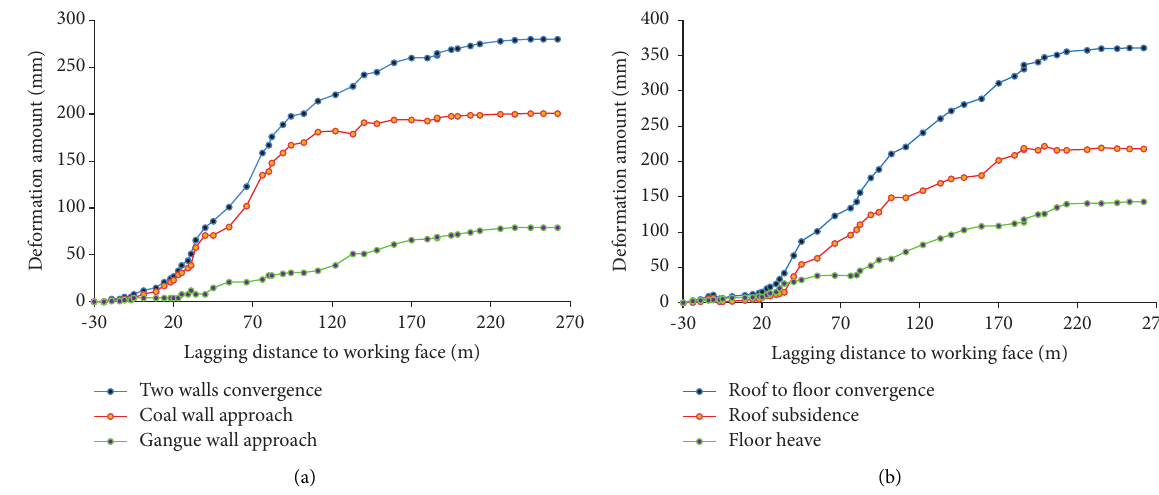
Figure 21: Monitoring results at 130m footage section. (a) Two walls convergence. (b) Roof to floor convergence.